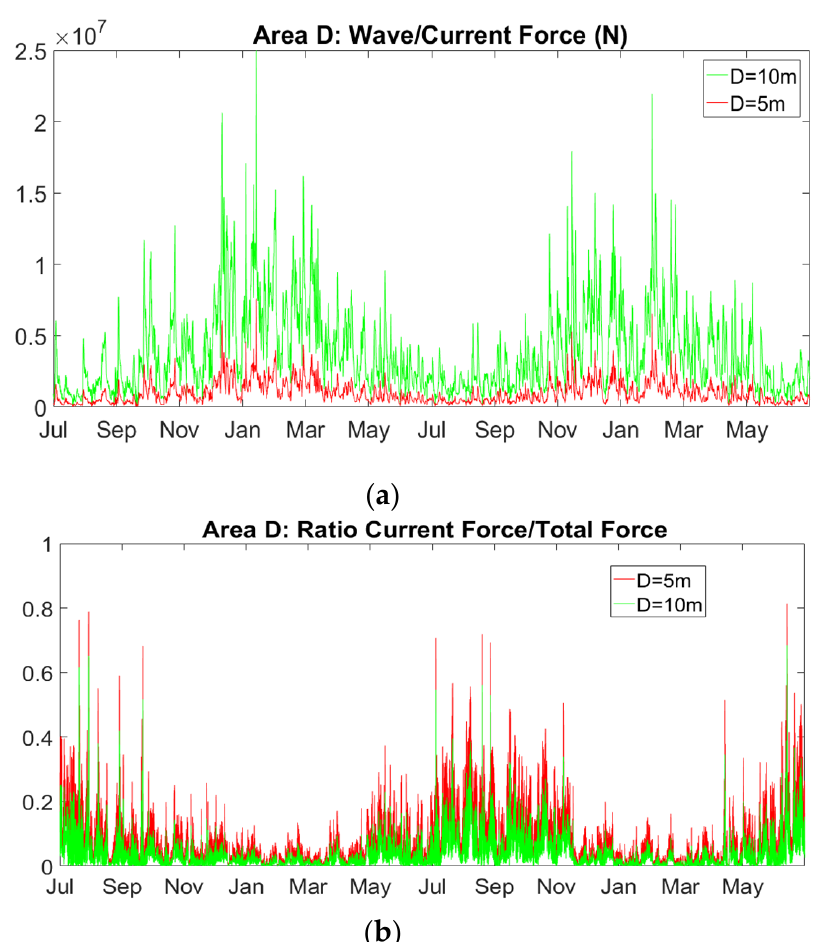
Figure 12. Hourly time series of area-averaged total wave/current force (N) ( a ) and ratio of current contribution to total force ( b ) in area D from July 2014 to June 2016 and for pile diameter 𝐷 = 5 m (red) and 𝐷 = 10 m (green).